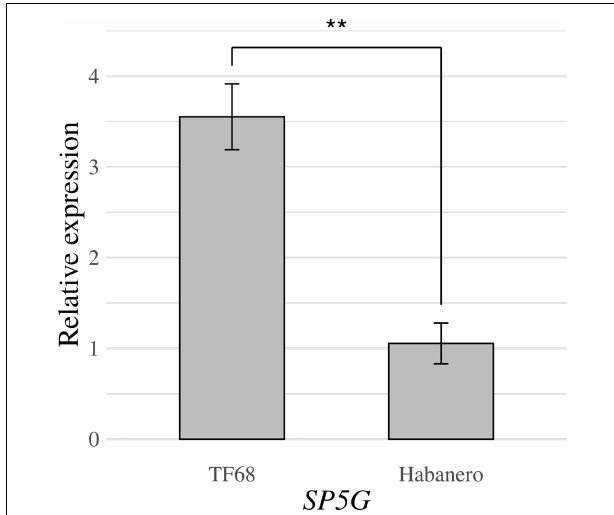
FIGURE 7 | Relative expression of the SP5G gene in the parental accessions ‘TF68’ and ‘Habanero,’ as determined by RT-qPCR. Asterisks indicate significant differences (** P < 0.01). P -value was determined by a two-tailed, two-sample t -test.